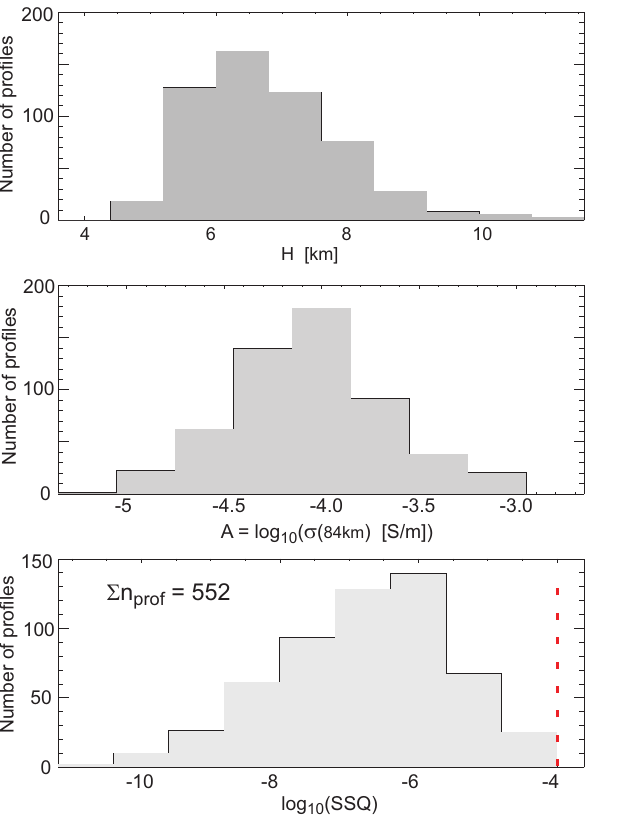
Fig. 4. Histograms of the two input parameters of our model, H and A , together with the goodness of the fit (Eq. 4). SSQ has been limited to values < 10 − 4 , that means that finally 552 profiles have been used for the model.